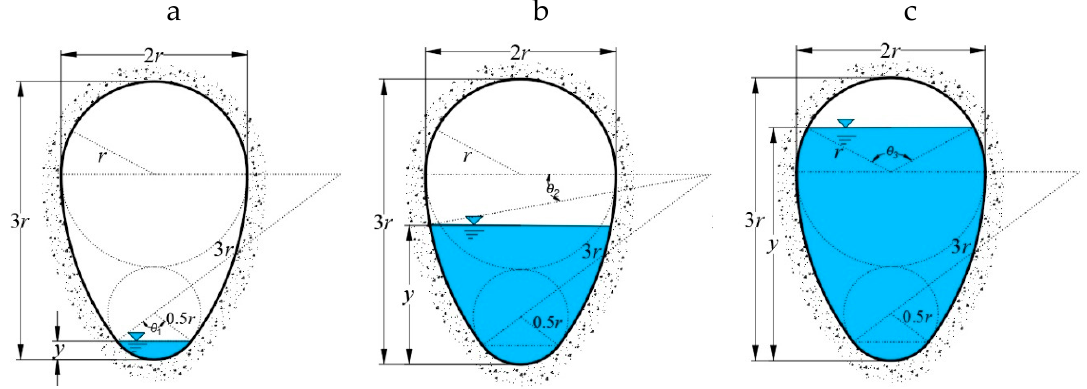
≤ y ≤ r / 5, ( b ) r / 5 ≤ y ≤ 2 r , ( c ) 2 r ≤ y ≤ 3 r